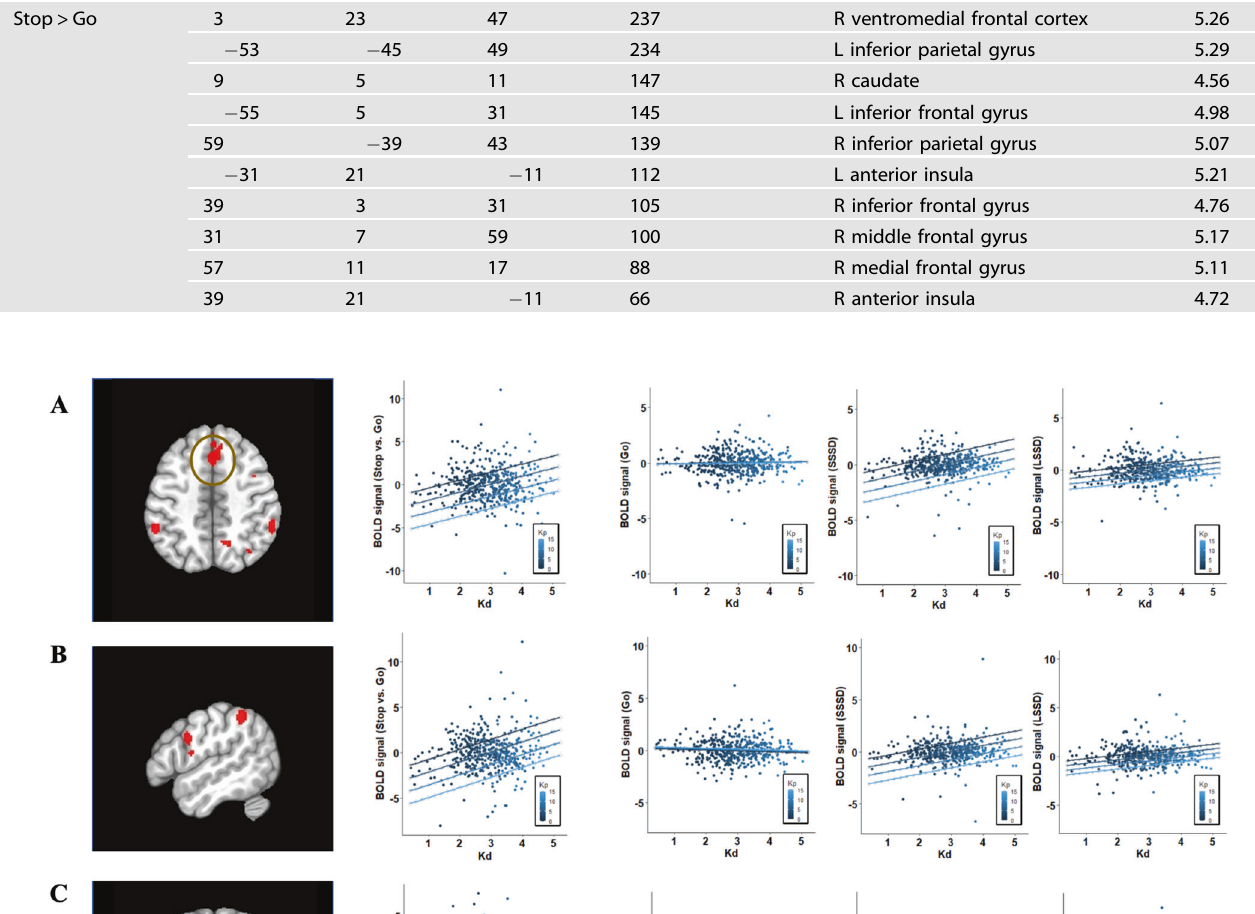
Table 2. Brain regions showing the relationship between K d and control activity during Stop-Signal Task. Peaks ( x , y , z